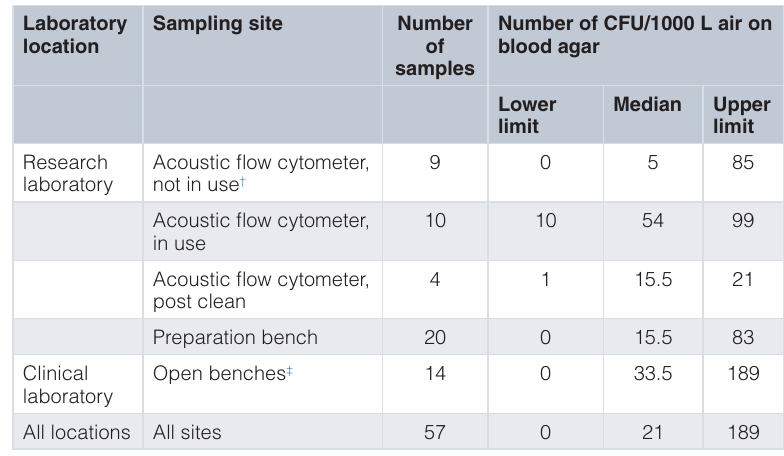
shown).Table Figure 1. Airborne bacterial count detected on blood agar increases in the research laboratory over the course of the day, both beside the acoustic-assisted flow cytometer (AFC) and at the preparation bench (PB) (respective regression lines Table 2. Bacterial counts (CFU/ 1000 L air) recovered from air sampled onto blood agar in the Research Laboratory or the Clinical Laboratory. † ‘In use’ refers to cytometer in operation for bacterial analysis. ‡ results from both sampling sites in the clinical laboratory were pooled for this